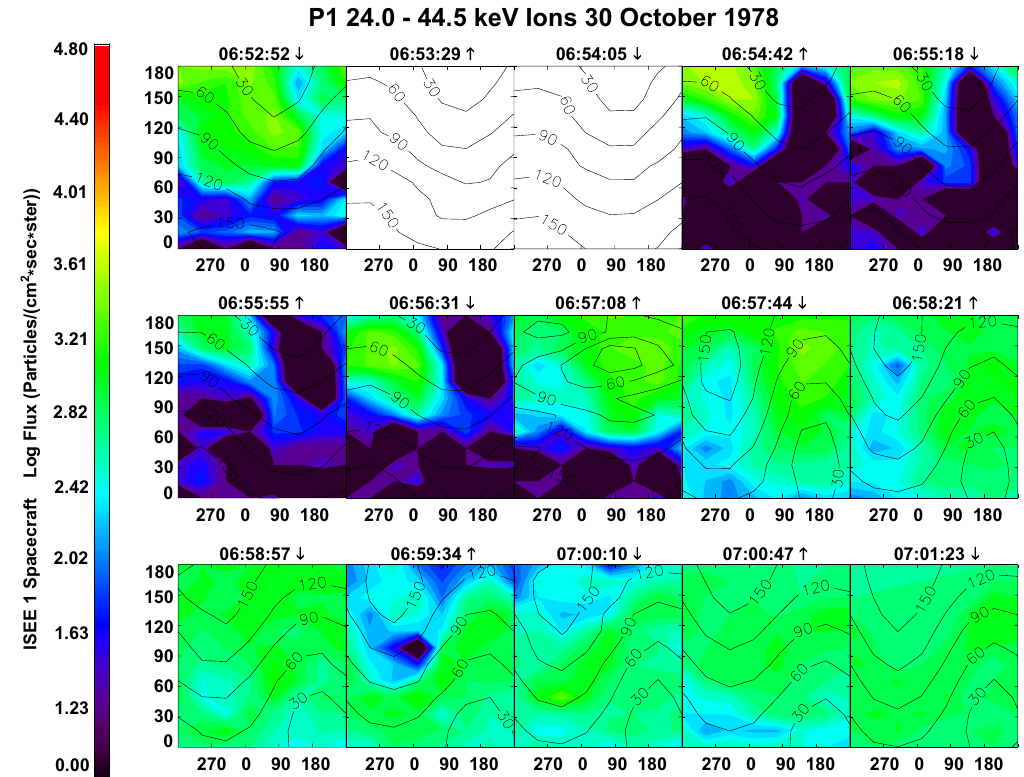
Fig. 9. A time sequence of northern hemispheric PADs for 24 to 44keV ions on 30 October 1978 (Day303) from (a) 06:26:09UT to 06:34:39UT and (b) beginning at 06:43:46UT and (c) ending at